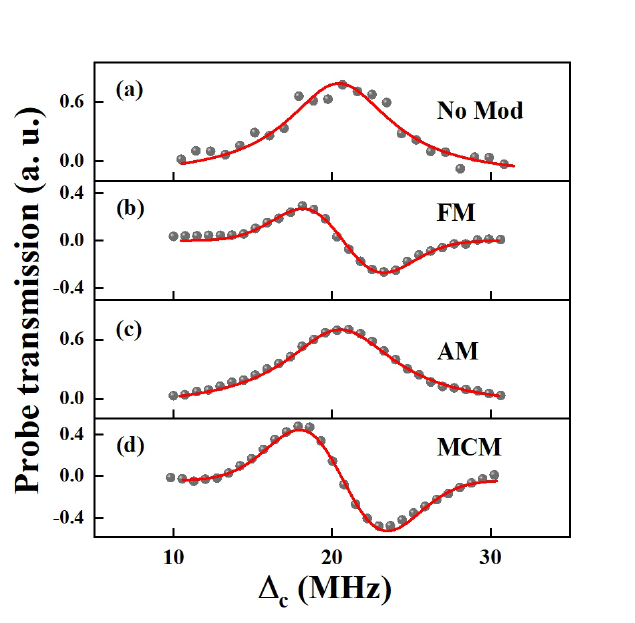
Figure 3. The right transmission signals of the AT splitting as a function of the coupling laser frequency detuning ∆ c in Figure 2e. ( a ) no modulation (No mod); ( b ) frequency modulation (FM); ( c ) amplitude modulation (AM); ( d ) multi-carrier modulation (MCM). The black dots are the experimental results and the red lines are the fitting results with Voigt